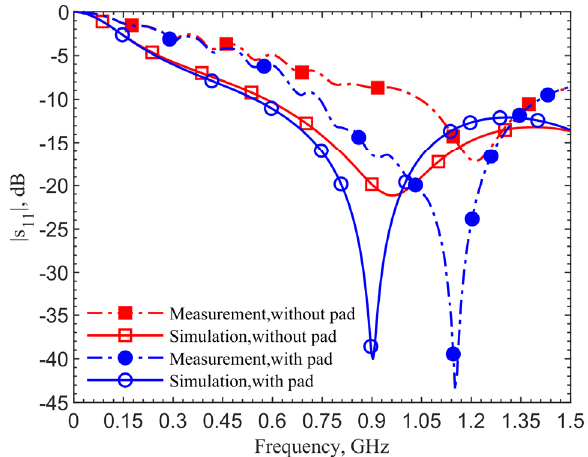
Figure 4 . Simulation and measurement results of the resonate couplers with and without the cen- ter pad. The design is for the ISM frequency band 902–928